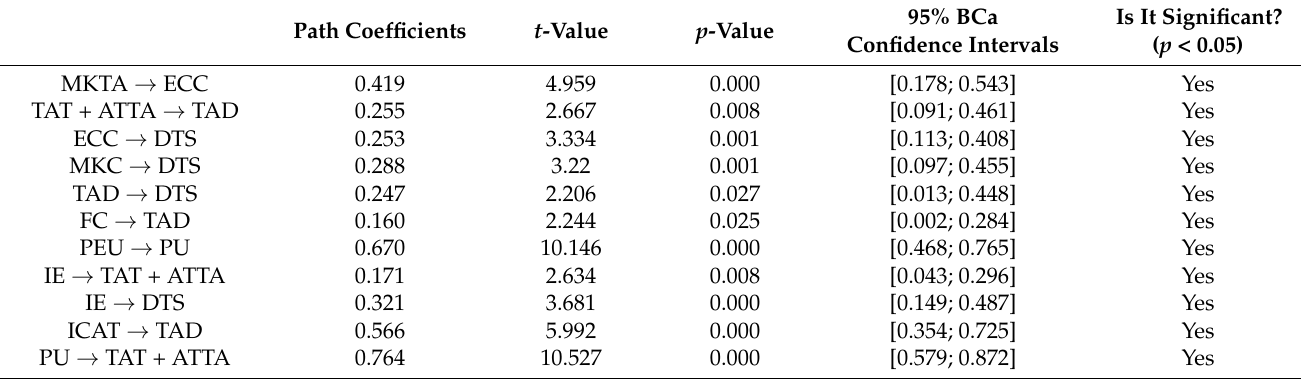
Table 11. Results of the significance test for the path coefficients (direct